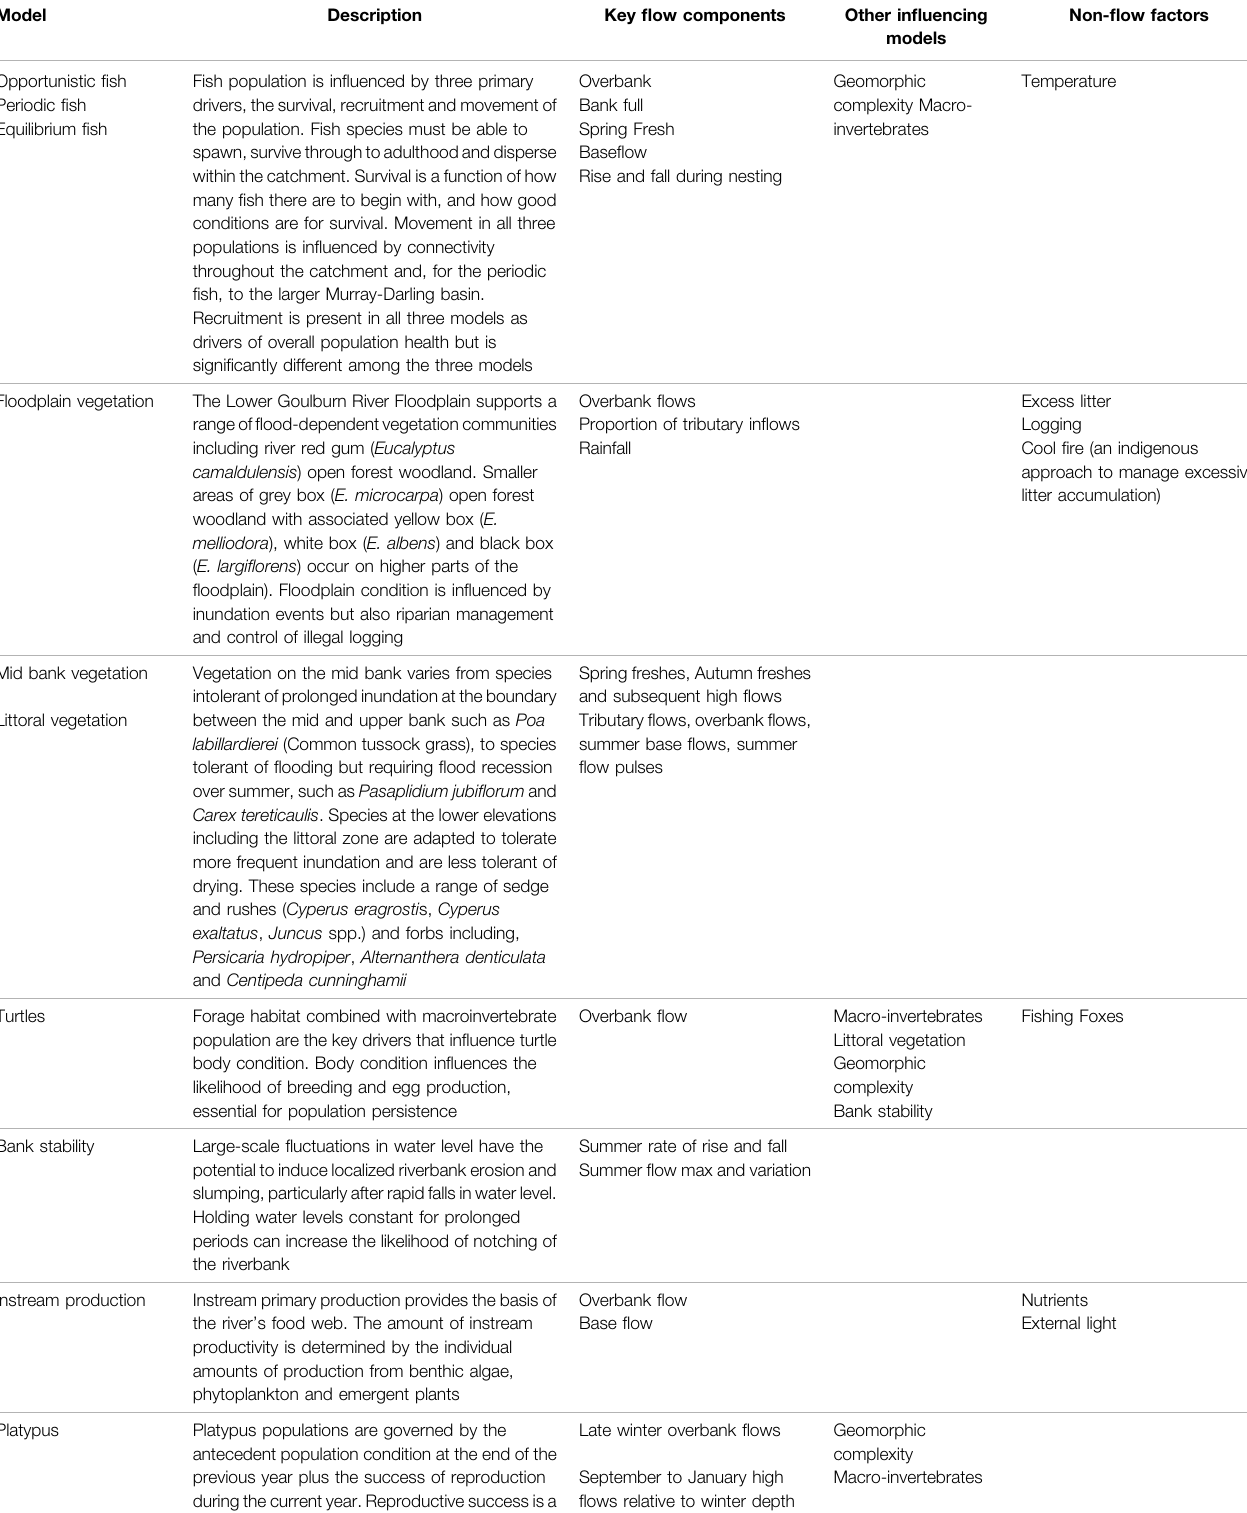
TABLE 2 | Models of twelve key ecological endpoints for the Goulburn River, including the fl ow components they rely on to support individual ecological